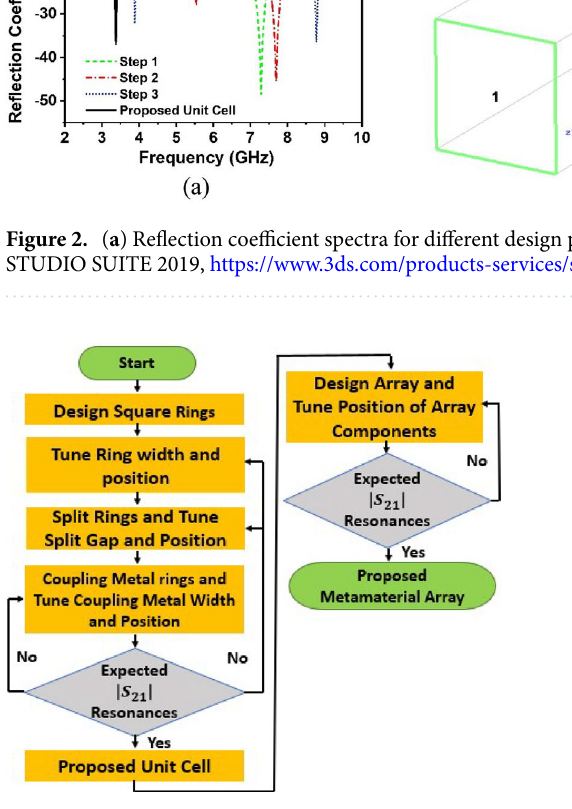
Figure 3. The flowchart for designing and optimizing the suggested MM